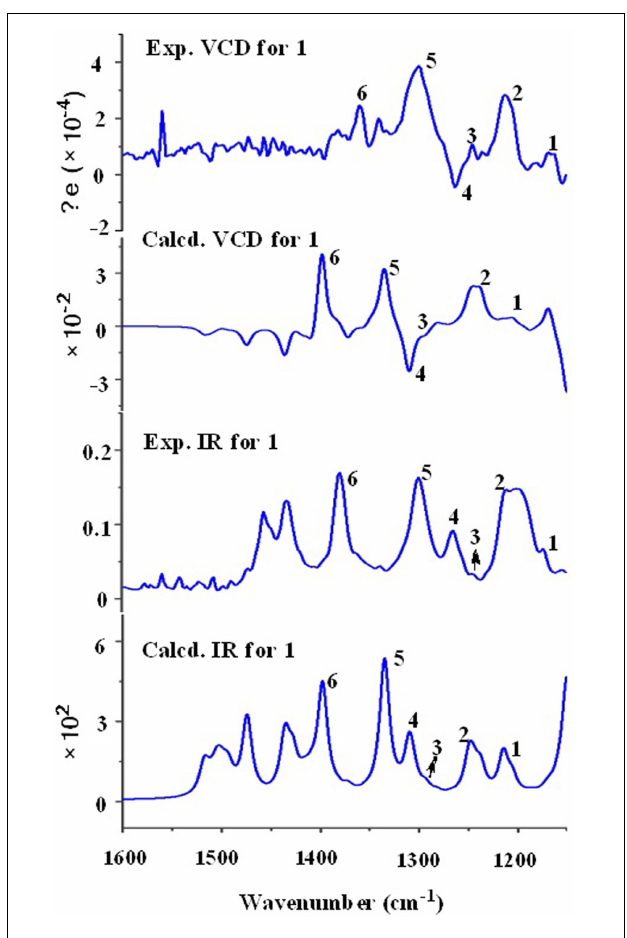
FIGURE 3 | Comparison of the calculated VCD/IR spectra of (1 R ,4 R ,5 R ,6 S ,7 S ,10 S ,12 R ,15 R ,16 S )- 1 and the experimental VCD/IR spectra of 1 .